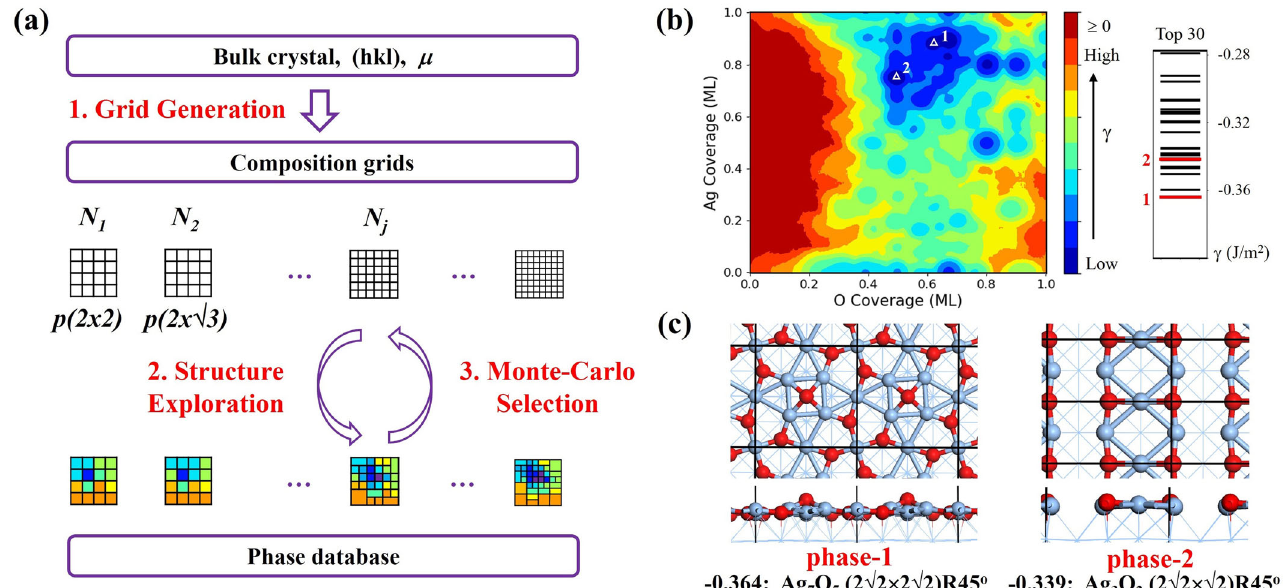
Fig. 2 The ASOP algorithm and its application. a Flowchart of the ASOP algorithm that contains three steps. b The PES contour map and energy spectrum for silver surface oxides on Ag(100) from ASOP simulation. c The geometries of two phases, as labeled in both PES map and energy spectrum. Reproduced with permission from ref. 91 . Copyright American Institute of Physics,